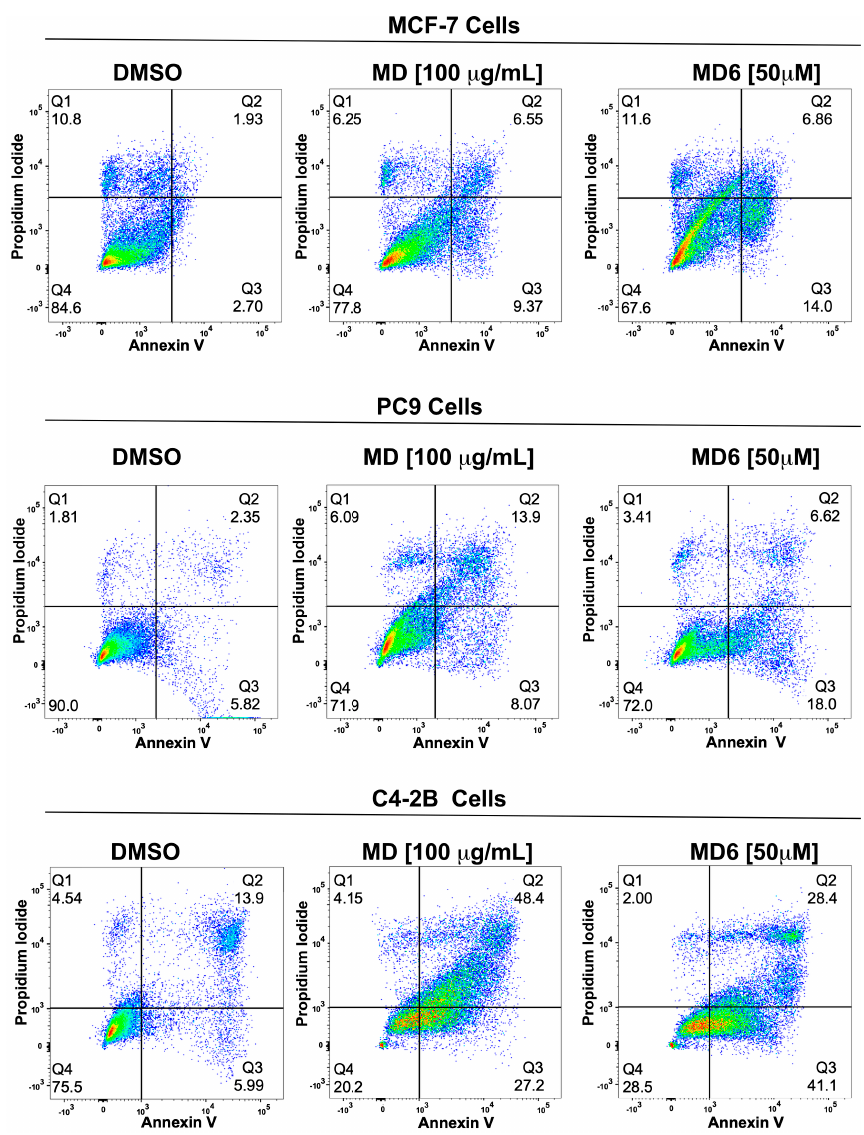
Figure 9. Apoptosis analysis on breast, lung, and prostate cancer cells treated with MD and MD-6 for 24 h. Detection of apoptosis by flow cytometry using annexin V / PI